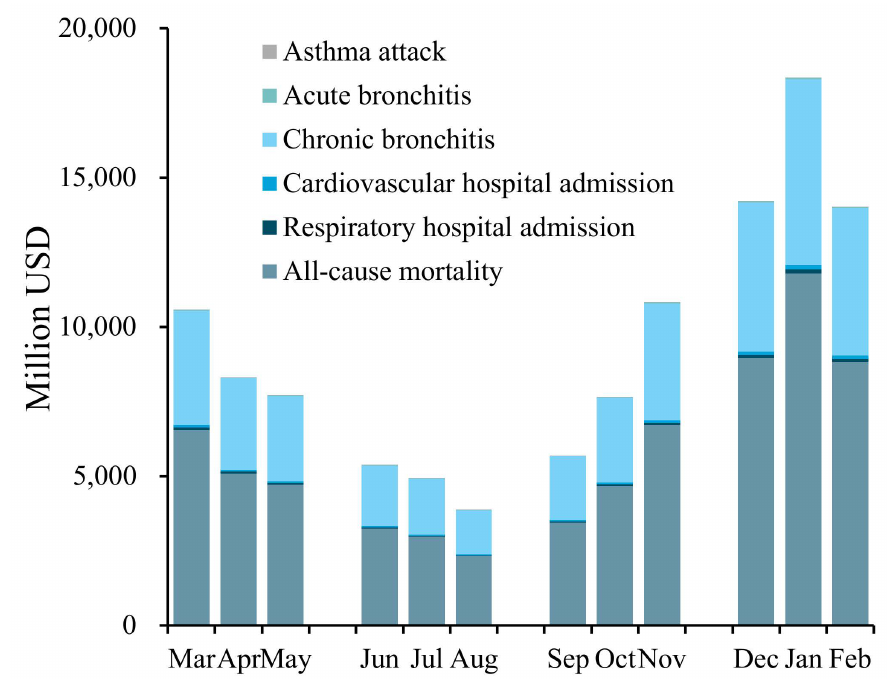
Figure 6. Estimation of the economic loss due to PM 2.5 exposure by month in